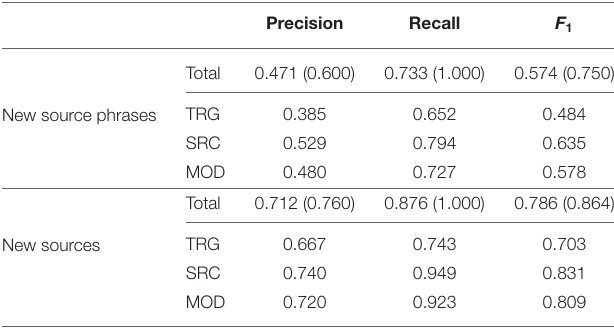
TABLE 10 | Evaluating predictions of BERT-50-SEQ from the NYT dataset in terms of new and unseen source phrases and sources, respectively. Precision Recall F